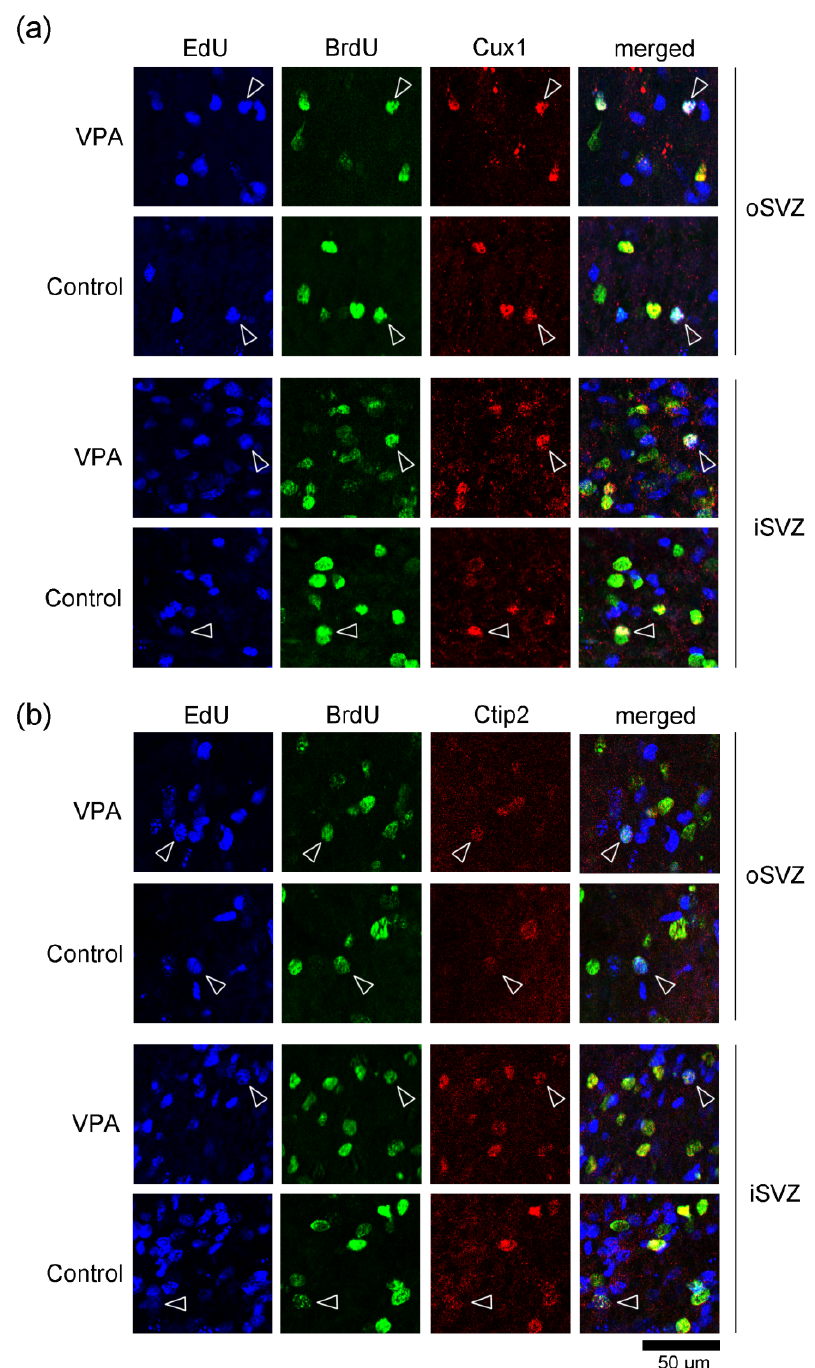
Figure 4. Immunofluorescence for postmitotic markers with EdU and BrdU labeling in the SVZ of the premature cortex of VPA ‐ exposed and control ferrets at PD 7. ( a ) High ‐ magnification images of Cux1 immunofluorescence with EdU and BrdU labeling in the oSVZ and iSVZ. Open arrowheads, Cux1 ‐ positive immature neurons with EdU/BrdU double labeling. ( b ) High ‐ magnification images of Ctip2 immunofluorescence with EdU and BrdU labeling in the oSVZ and iSVZ. Open arrowheads, Ctip2 ‐ positive immature neurons with EdU/BrdU double labeling.